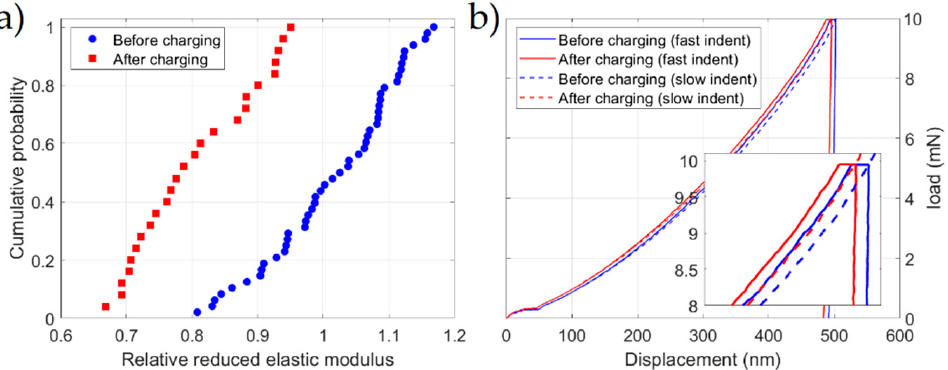
Figure 3. ( a ) Plot of reduced elastic modulus determined from Hertzian loading. ( b ) Load-displacement data of hardness measurements (averaged across 10 indents).